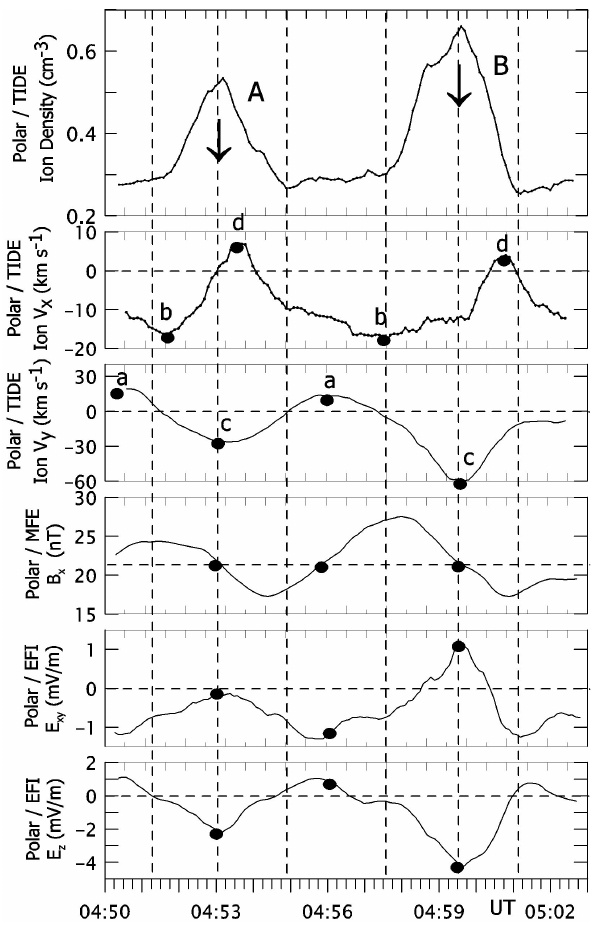
Fig. 3. Two variation cycles of POLAR ion density (top panel) asso- ciated with the ion velocities V x and V y (second and third panels), the magnetic field B x toroidal wave (fourth panel) and the electric field E xy and E z components (in mVm − 1 ) .